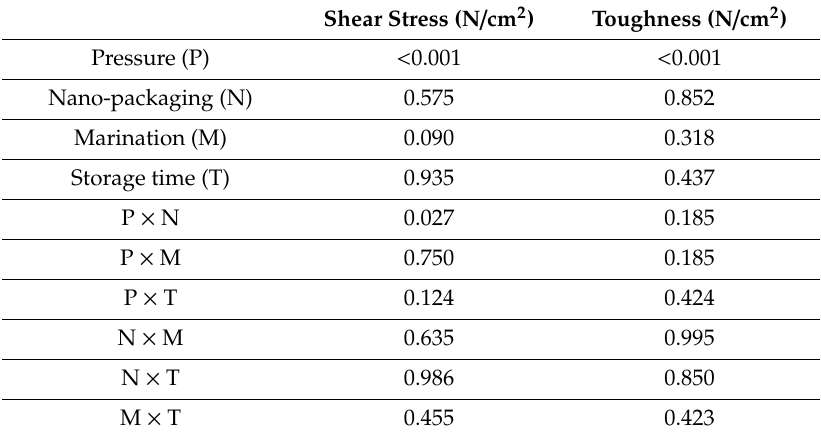
Table 3. The p -values for the e ff ects of the studied factors (pressure application, packaging type, marinade immersion and storage time) on beef shear stress and toughness.